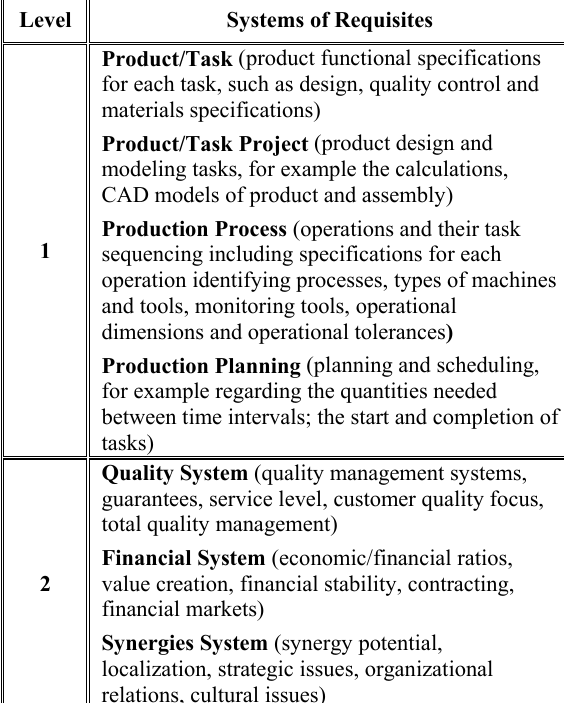
Figure 5. Indirect negotiation with VA